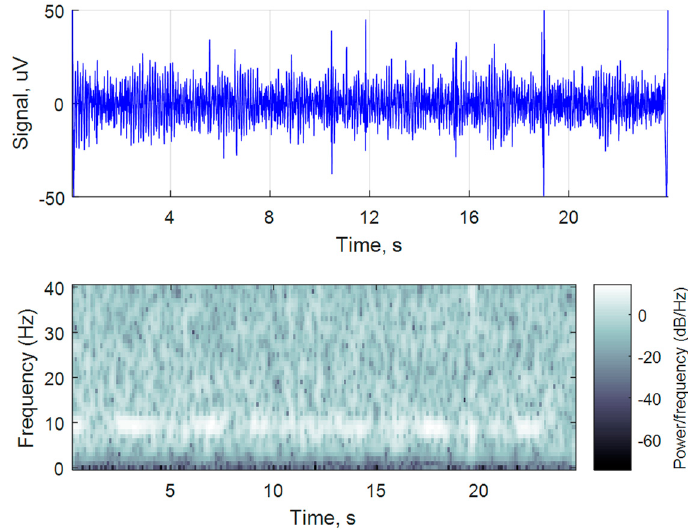
Figure 8. Alpha waves detection from recorded EEG signal.